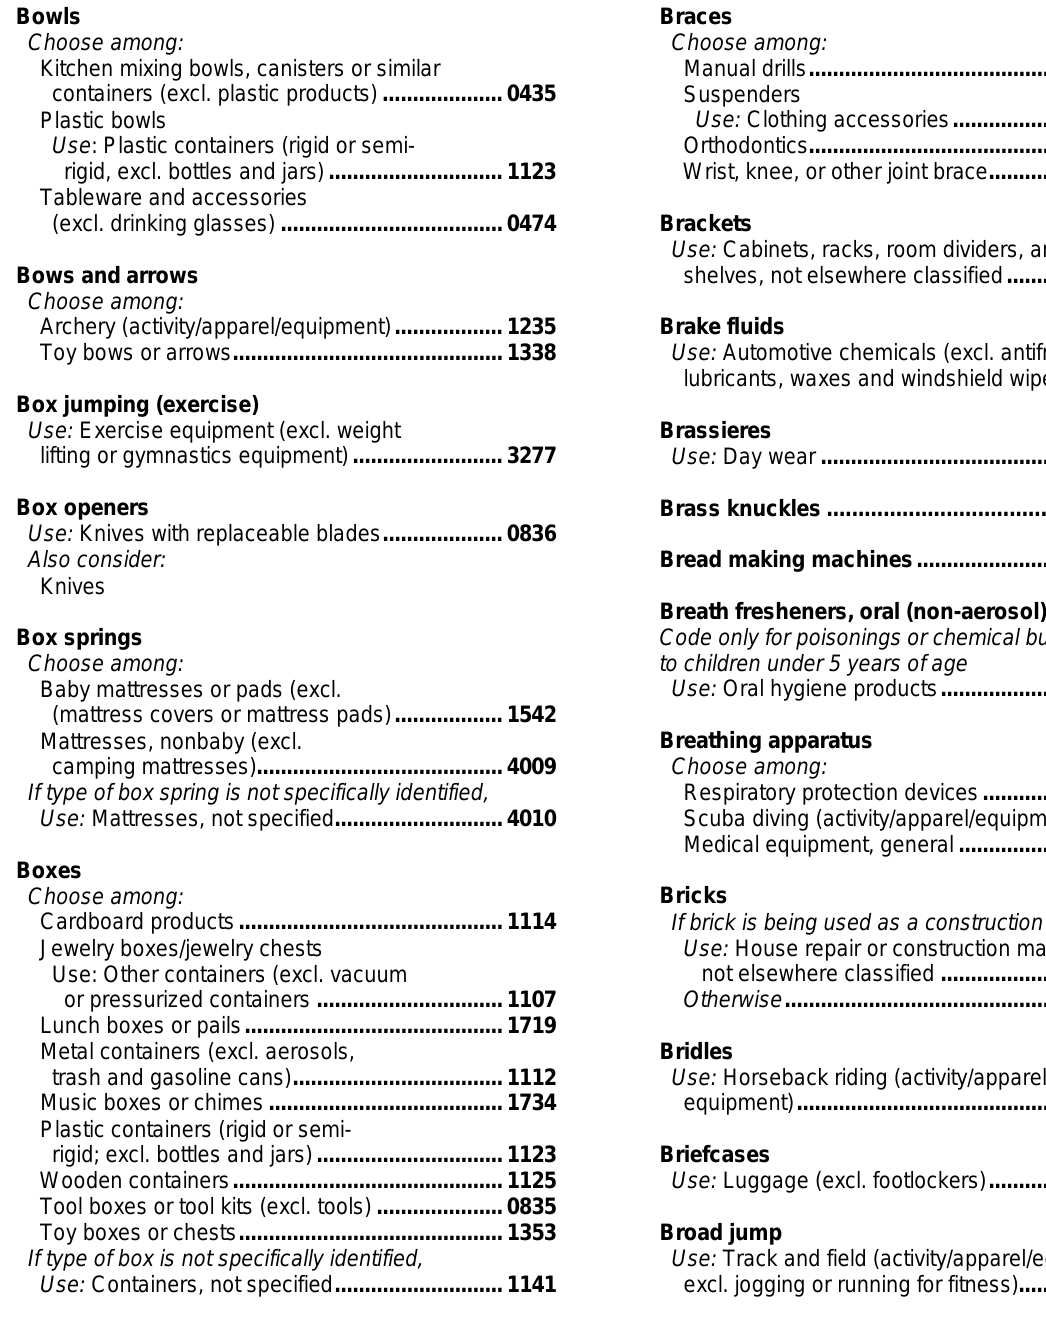
If type of box is not specifically